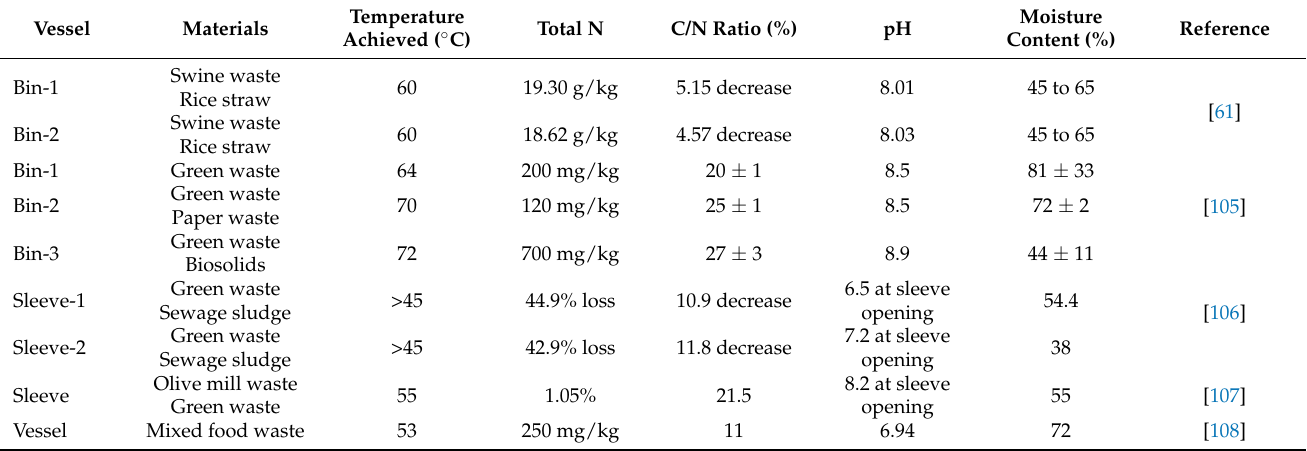
Table 6. Physicochemical characteristics of different materials in